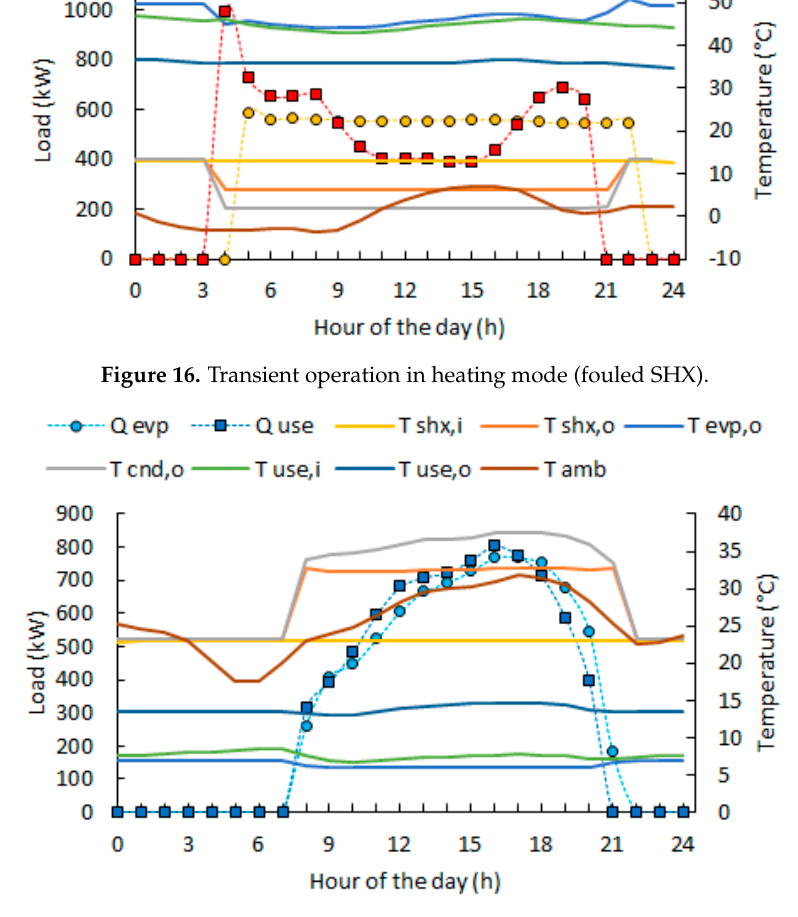
Figure 17. Transient operation in cooling mode (clean SHX).